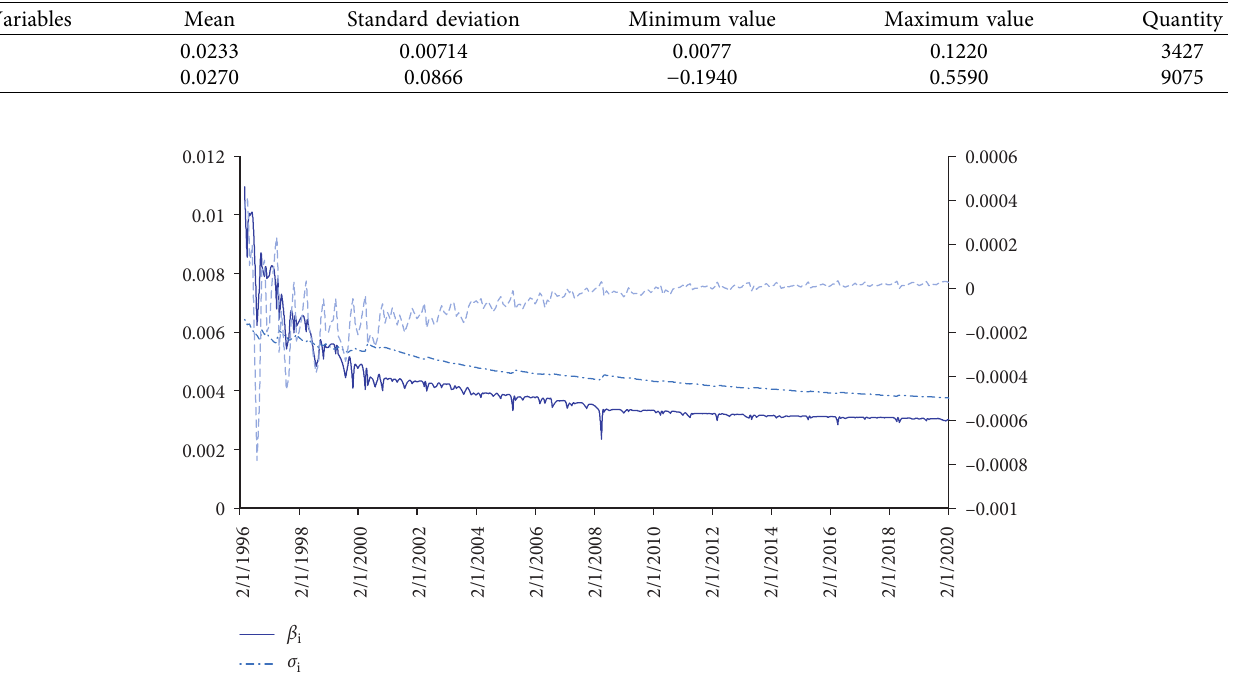
Figure 1: Changes of the parameters in the inflation rate model from 1996 to 2020 (note: the value of α the remaining variables are the left-side primary axis).